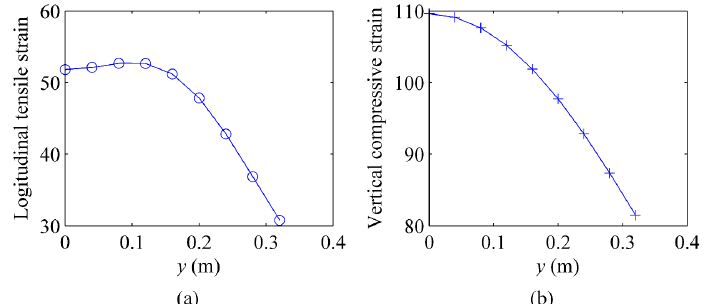
Figure 7. Deterministic results for ( a ) longitudinal tensile strain at the bottom of the asphalt layer and ( b ) vertical compressive strain on the top of the subgrade.